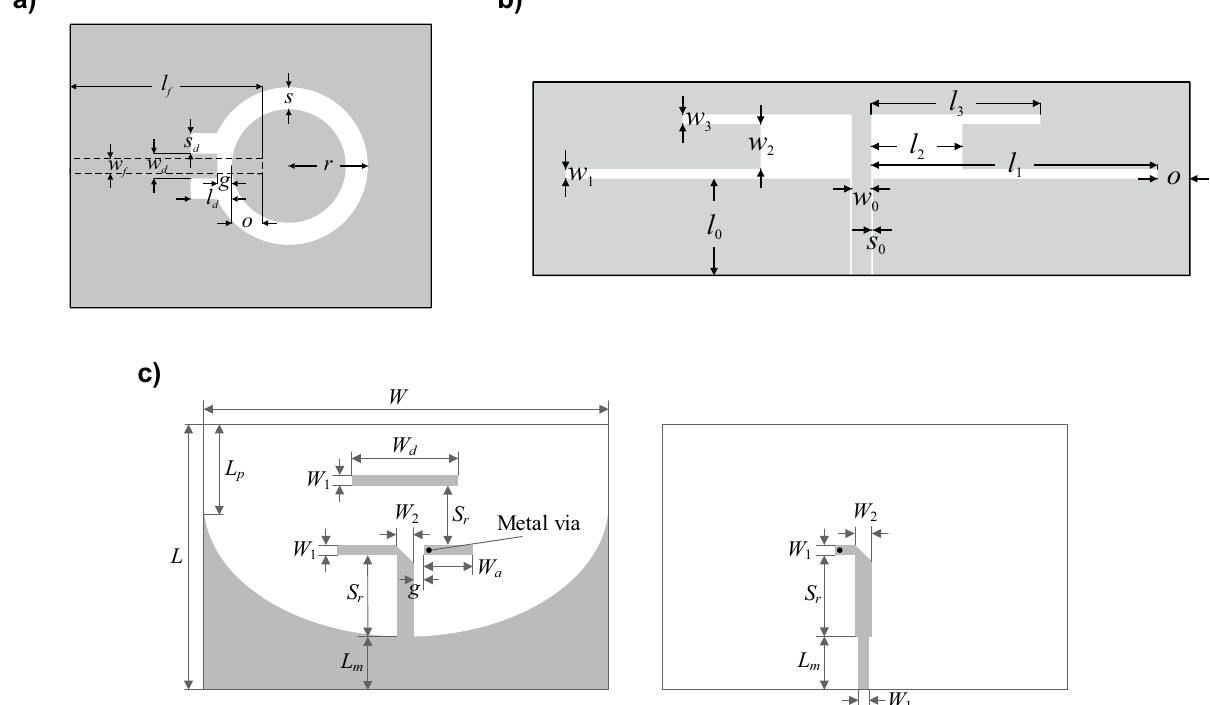
Figure 4. Geometries of the benchmark antenna structures: ( a ) ring slot antenna 56 (Antenna I) with microstrip feed marked using a dashed line, ( b ) dual-band dipole antenna 57 (Antenna II), and ( c ) quasi-Yagi antenna 58 (Antenna III) top layer (left), and bottom layer